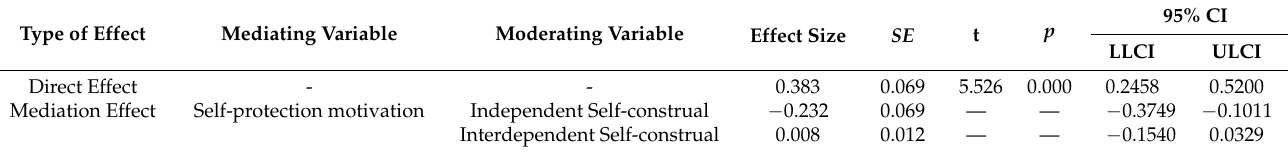
Table 2. Mediating role of self-protective motivation in moderating